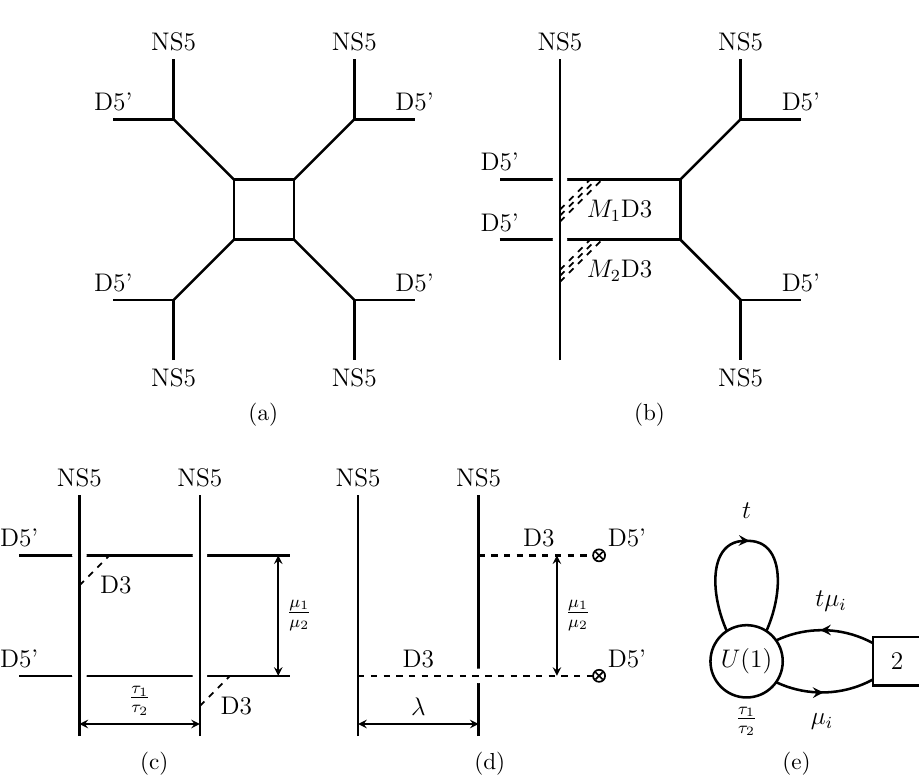
Figure 6 . (a) ( p; q )-brane web S , corresponding to the 5 d U(2) square gauge theory. The picture can also be viewed as the toric diagram of the CY. Compactifying M-theory on this CY one arrives at the same gauge theory. (b) One NS5 brane is separated in the transverse direction, so that the gauge theory goes onto the Higgs branch. The dashed lines denote two stacks of M 1 and M 2 D3 branes respectively stretching between the NS5 and D5’ branes. One can also view this picture as describing the CY background after the geometric transition. (c) The brane setup corresponding to the 3 d FT [SU(2)] theory where M 1 = 1 and M 2 = 0. The masses (cid:22) 1 ; 2 and FI parameters (cid:28) 1 ;